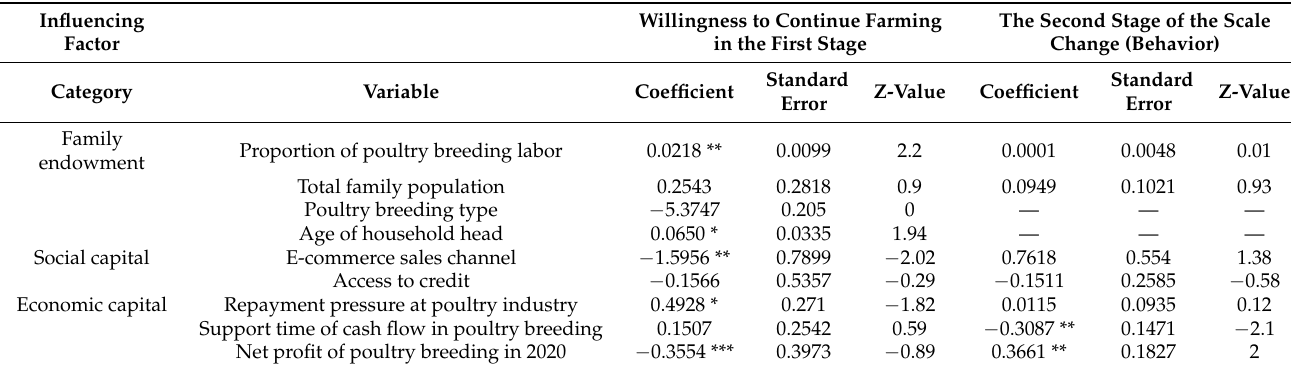
Table 3. Regression results of Heckprobit two-stage